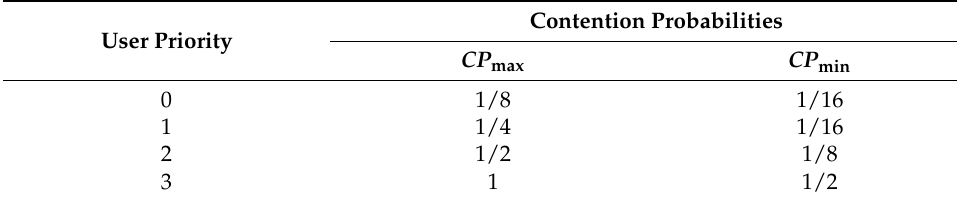
Table 3. Contention probabilities for different user